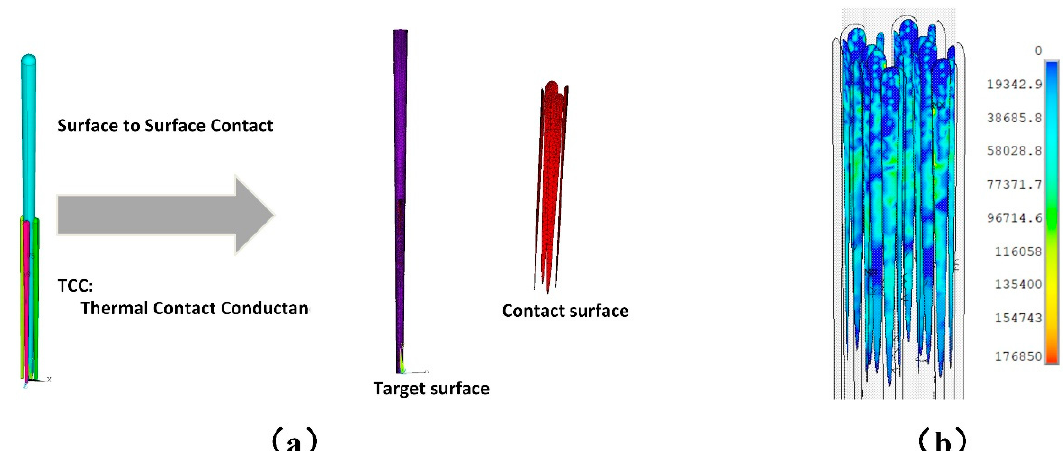
Figure 3. ( a ) The thermal contacting pair in simulation, and ( b ) heat flux field of the thermal contact pairs.